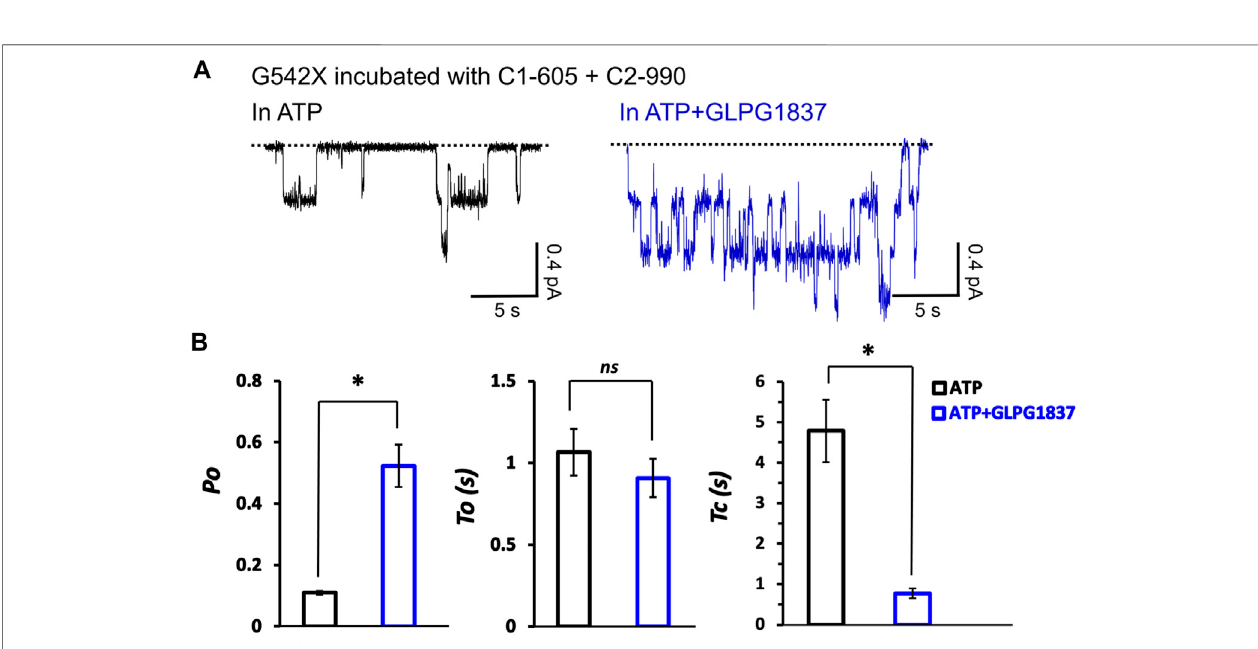
FIGURE 9 | Single-channel behaviors and responses to channel modulators for G542X-CFTR read-through protein. (A) Single-channel recordings of G542X- CFTR treaded with and C1-605 (0.5 μ M) + C2-990 (3 μ M), respectively, in the presence of 2 mM ATP (black) and 2 mM ATP +3 µM GLPG 1837 (blue). (B) Statistics of open probability ( Po ), open time ( τ o ), and closed time ( τ c ). The data are represented as mean ± SEM. (N = 3, Student ’ s t -test). * p < 0.05. ns presents no signi fi cant increase.